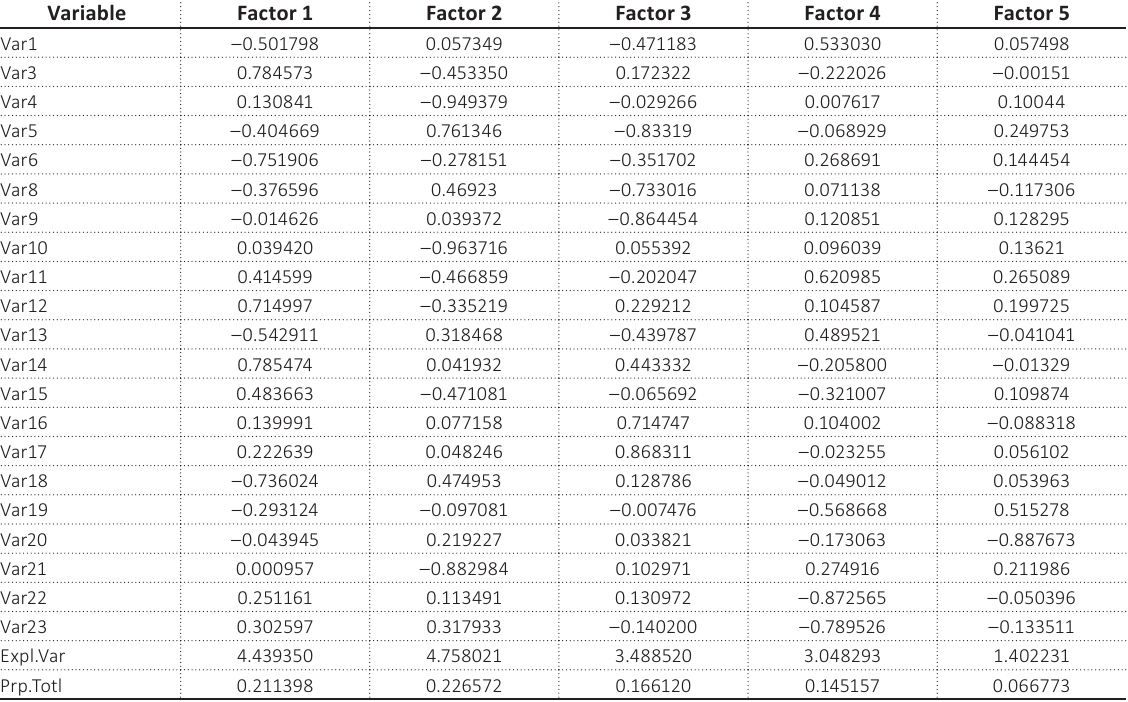
Table 1. Results of factor analysis by the principal component